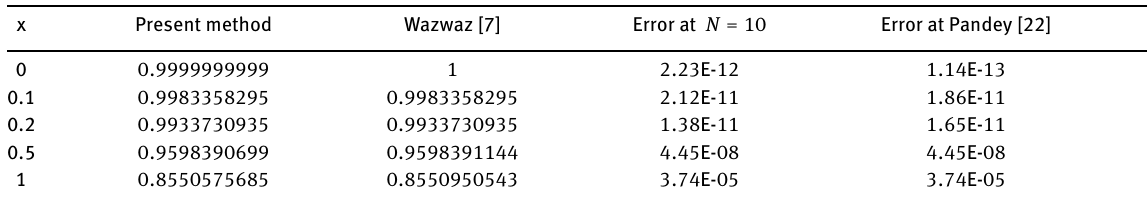
Table 1: Comparison of approximate solutions and error obtained by modified method with series solution wazwaz [7] and newly advanced method Pandey [22] for Example 3.